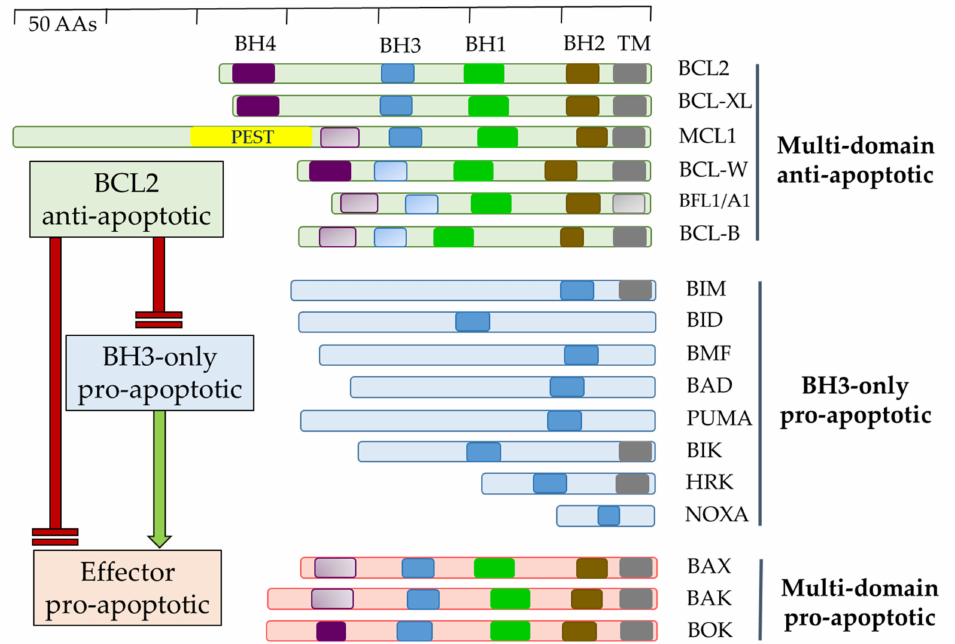
Figure 1. Overview of mammalian proteins of the BCL2 family. Multidomain anti-apoptotic and pro-apoptotic BCL2- homology (BH) BH1-BH4 domains, and transmembrane (TM) domains are shown as opaque; presumed BH and TM domains are shown as transparent. PEST—signal peptide for protein